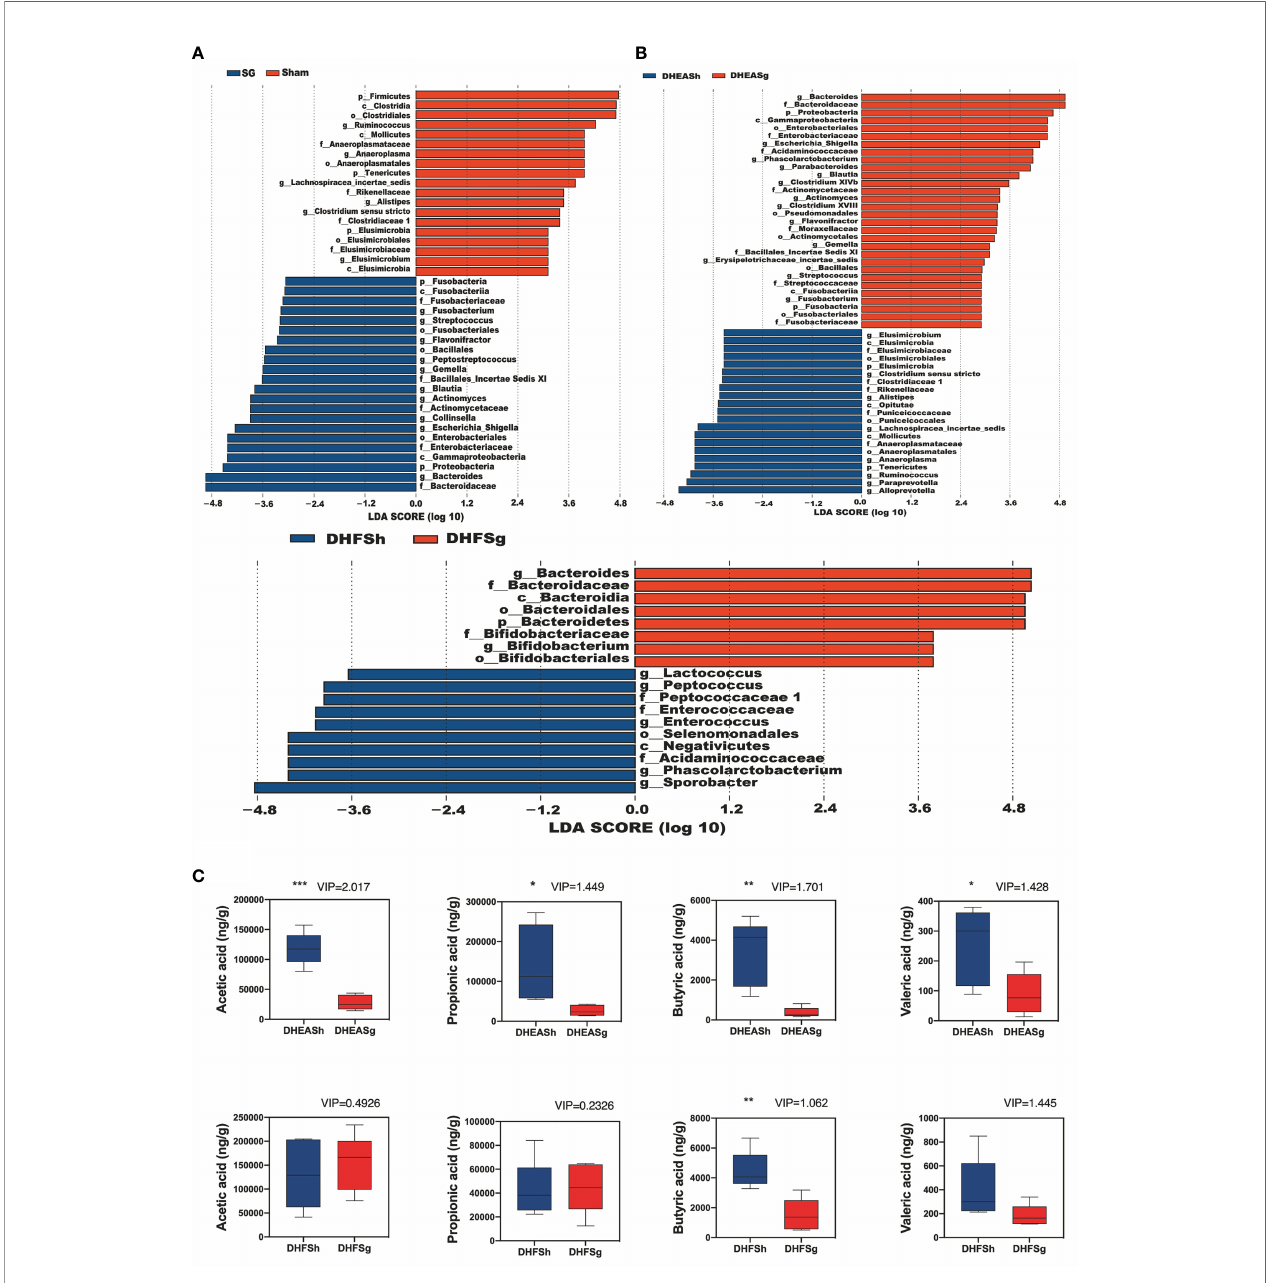
FIGURE 2 | Effects of SG on shifts in gut microbiota and short chain acid contents. (A) LDA effect size (LEfSe) analysis between the SG and sham groups and between the DHEASg and DHEASh groups. (B) LEfSe analysis between the DHFSg and DHFSh groups. (C) Boxplots show changes in the levels of acetic acid, propionic acid, butyric acid, and valeric acid. *p < 0.05. **p < 0.01. ***p <